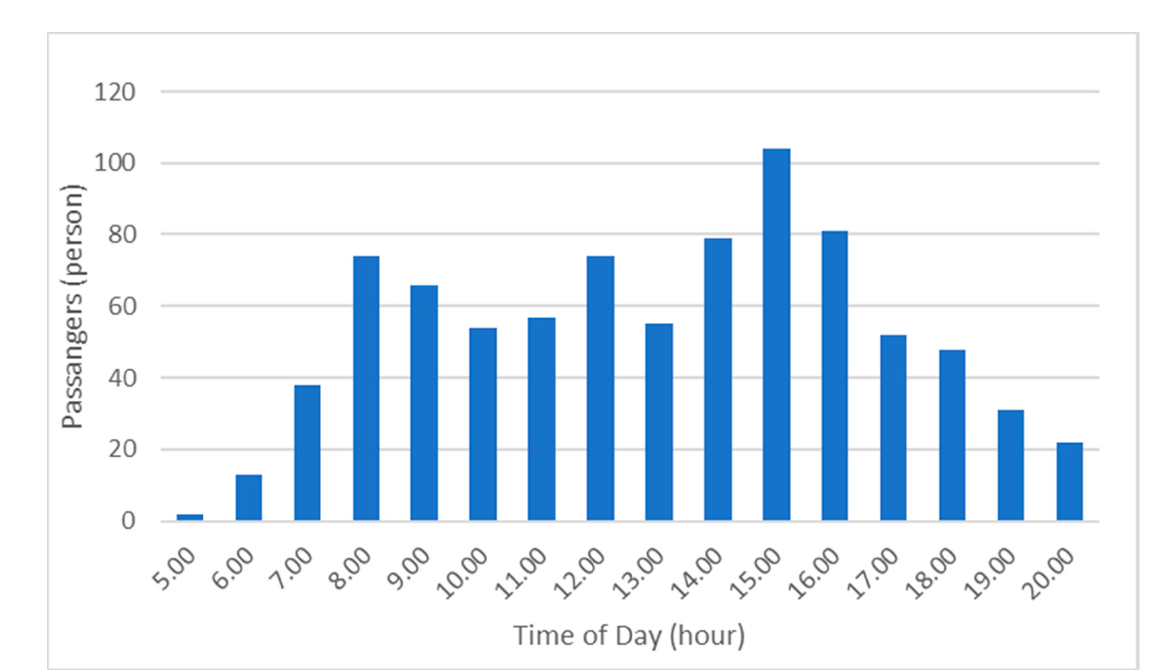
Figure 10. Passengers on one bus shift (13 February 2020).